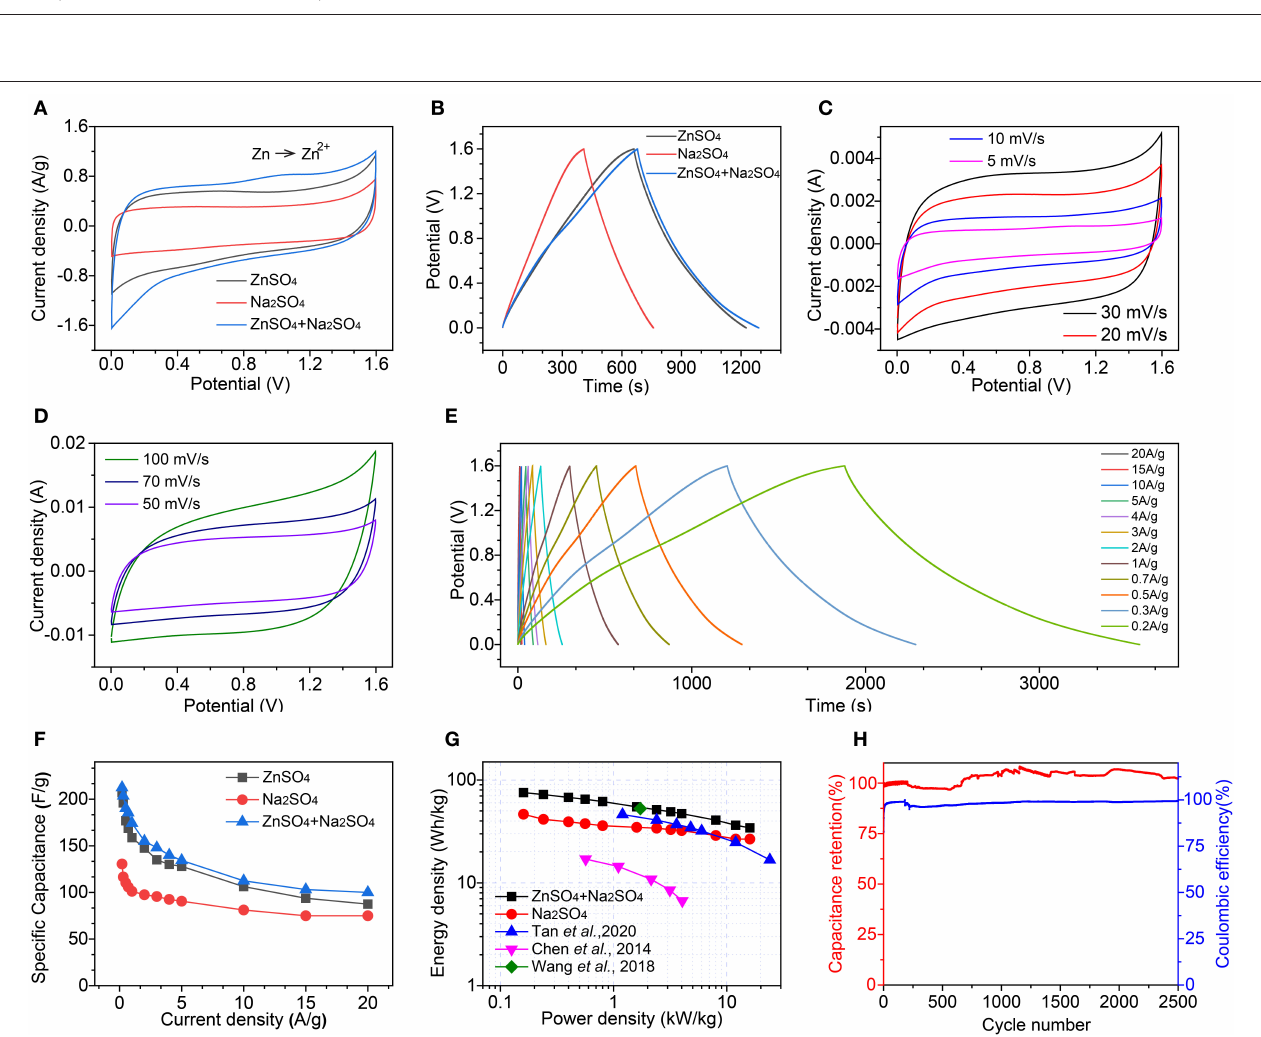
FIGURE 3 | Electrochemical performance of symmetric electrochemical energy storage devices, constructed by as-synthesized HMCS as electroactive materials and three different electrolytes, 1M Na 2 SO 4 , 2M ZnSO 4 , and their mixture. (A) CV curves of these three devices at 5 mV/s. (B) Charge–discharge curves at 0.5 A/g. (C,D) CV curves and (E) charge-discharge curves at different scan rates or current densities, respectively. (F) The calculated specific capacities at different current densities. (G) Ragone plots of the electrochemical energy-storage devices and compared to previously reported results (Chen et al., 2014; Wang et al., 2018; Tan et al., 2020). (H) The cyclic stability and columbic efficiency of the